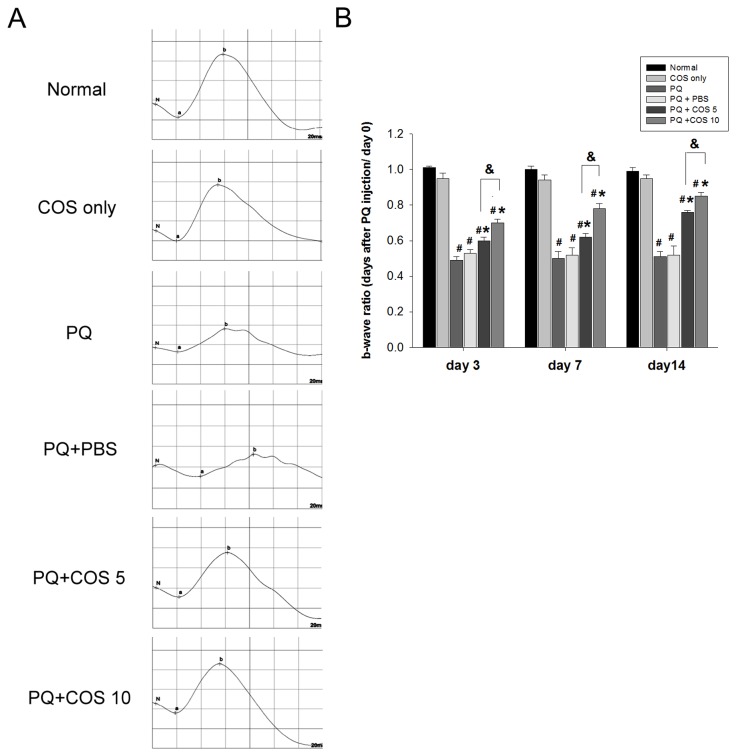
Chitosan oligosaccharides (COS) treatment attenuated reduction of electroretinogram (ERG) b- wave amplitudes.(A). Individual typical ERG records of the six groups 14 days after PQ injection. (B). Mean ERG b-wave amplitude was measured at day 3, 7 and 14 after PQ injection. The b-wave ratio was defined as b-wave amplitude of right eye/ b-wave amplitude of left eye at definite time point. The fold of b-wave ratio represented the b-wave ratio at day 3, 7 or 14 / b-wave ratio at day 0. The results represented six rats for each group in each time point. (*P < 0.05 compared with PQ only or PBS-treated group; # P < 0.05 compared with normal; & P< 0.05 by two-way ANOVA with post hoc Bonferroni test).